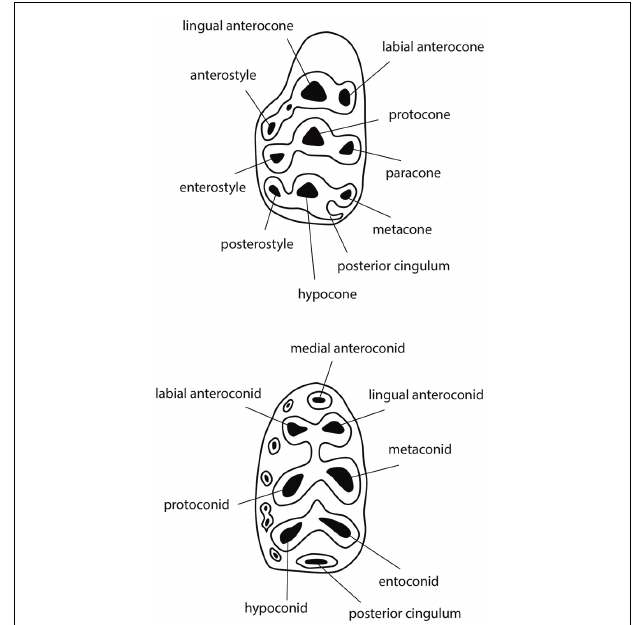
FIGURE 2 | Diagrams of typical murine first molars, upper (above, M1) and lower (below, m1), with cusp nomenclature. Major cusps are labeled, anterior is to the left. Upper molar shows cusps arranged in transverse chevrons; lower molar shows six major cusps in opposed pairs. The axis of the upper molar metacone-hypocone complex is termed a